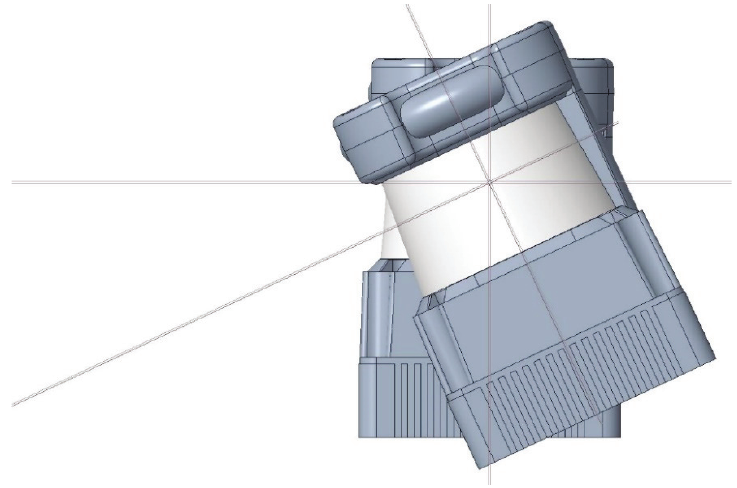
Figure 10. Illustration of the strategy applied to tilt down 25° the onboard 2D LIDAR. The horizontal line depicts the location of the measurement plane of the laser beam.